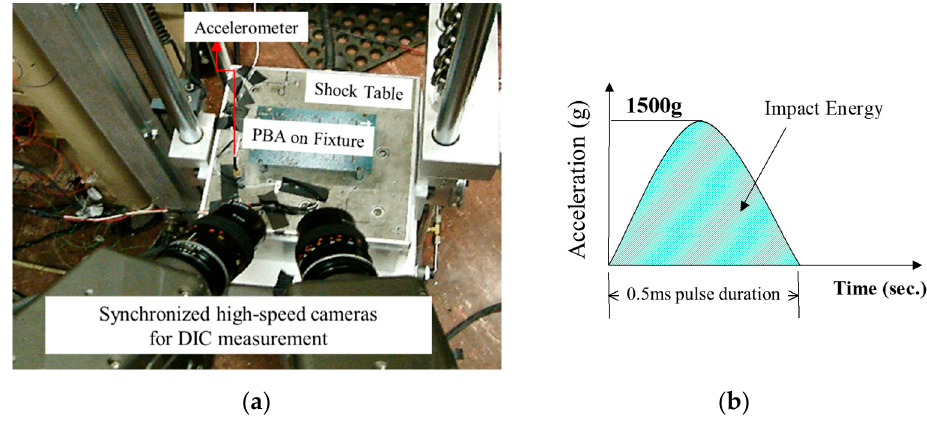
Figure 5. Experimental setup: ( a ) drop test system and digital image correlation (DIC) measurement equipment, ( b ) half-sine input pulse.